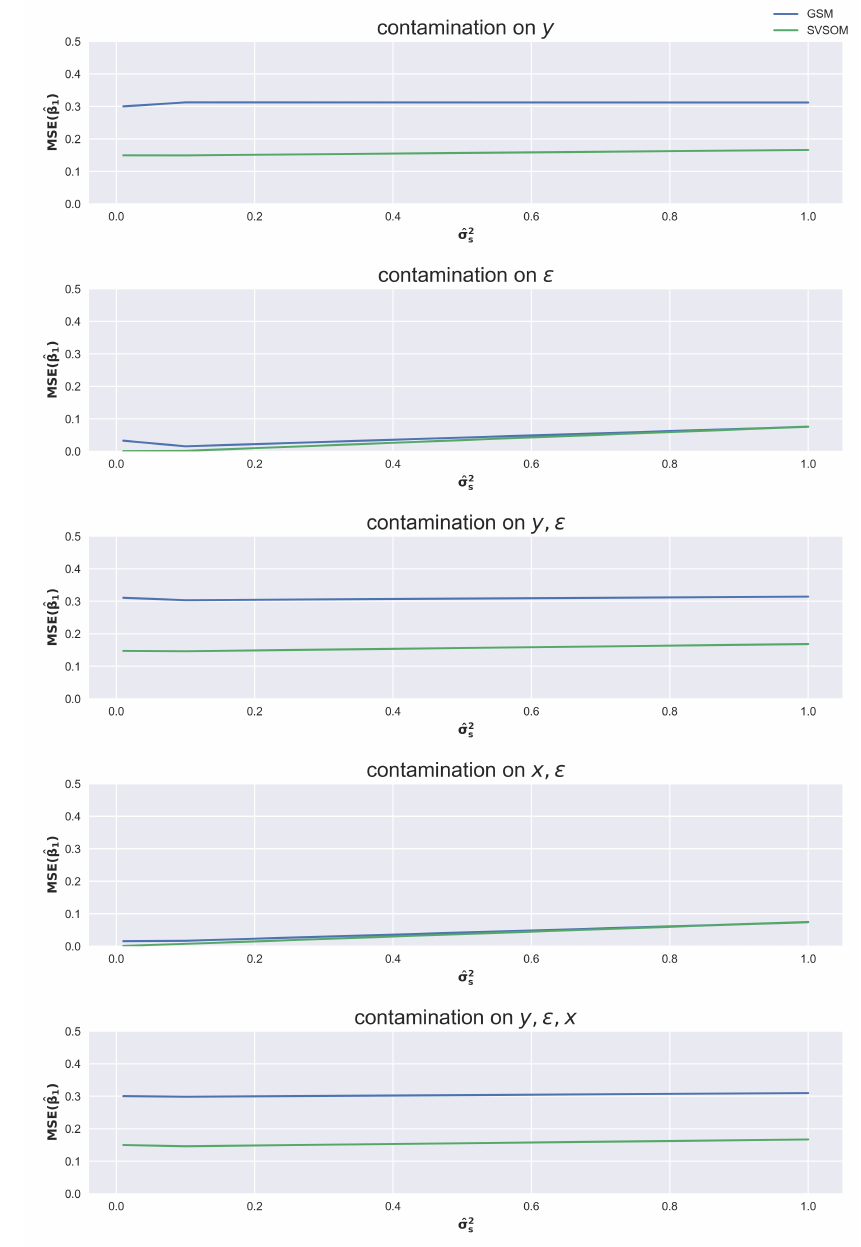
Figure 3. The graph of ˆ σ 2 s against MSE ( ˆ β 1 ) for ρ = 0.4 and λ = 0.5 from different sources of